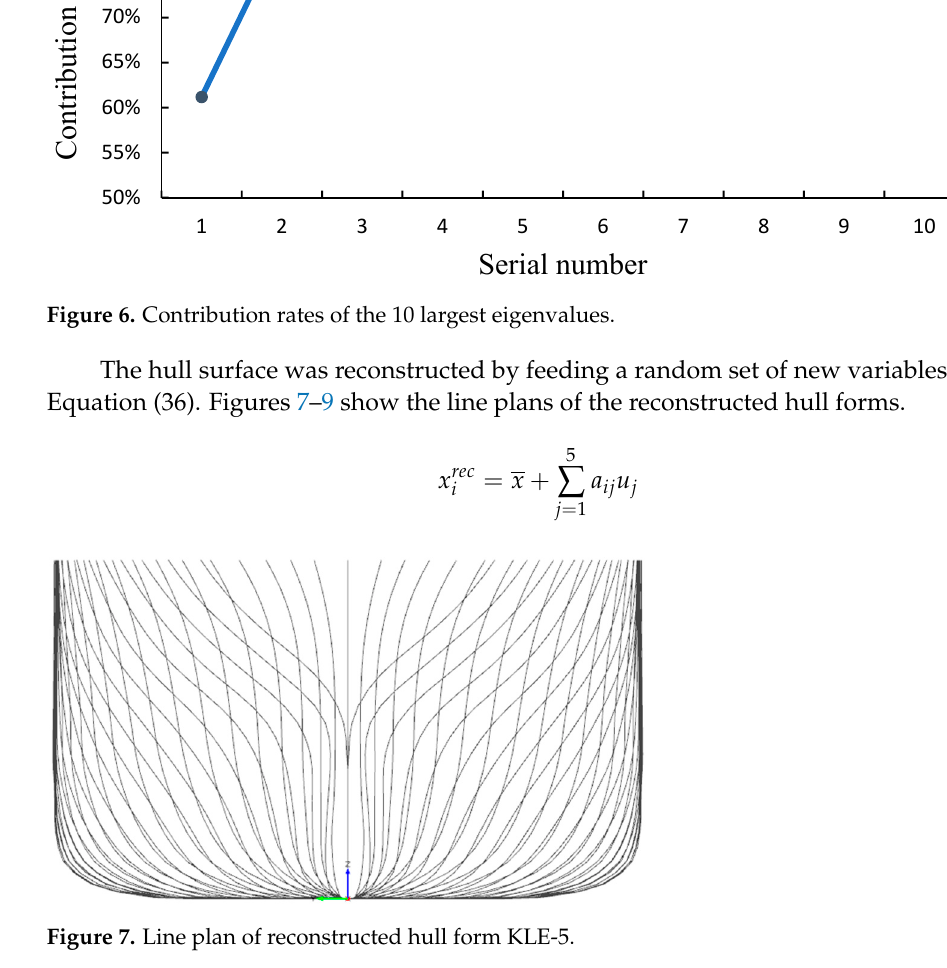
Figure 7. Line plan of reconstructed hull form KLE-5.